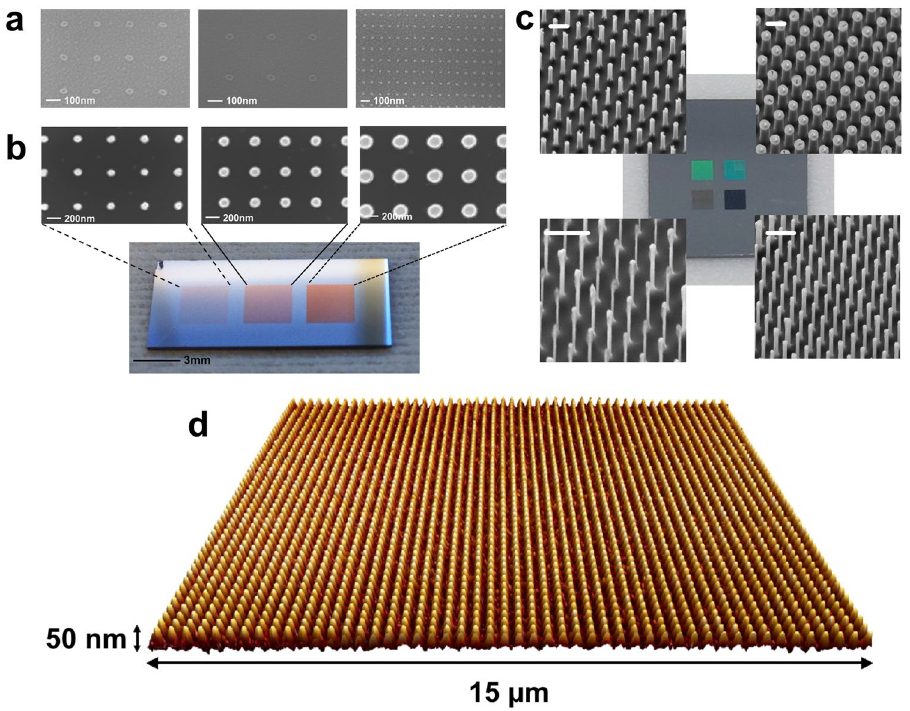
Figure 2. SEM, AFM and optical images of nanoarrays. ( a ) Scanning electron microscope (SEM) images of the HSQ nanodot arrays (height and diameter = 30 nm) fabricated on an ITO coated SiO 2 /Si substrate. The array period varies from 200 nm (left image), 300 nm (middle image) to 90 nm in the x-direction and 120 nm in the y-direction (right image). ( b ) Optical image of three sets of 3 mm × 3 mm gold nanodot arrays fabricated on a Si substrate. The array period is fixed at 500 nm. The SEM images show the corresponding diameters of the gold nanodots: 110 nm (left image), 170 nm (middle image) and 210 nm (right image). The optical image shows a difference in reflectivity intensities due to the difference of the fill factor of the gold nanodot array. ( c ) Optical image of four sets of 1.5 mm × 1.5 mm Si nanopillar arrays fabricated on a Si chip. The height (H) of the nanopillars is 950 nm. The optical reflectivity of the Si surface can be adjusted by the pillar diameter and array period. The SEM images show the corresponding array dimensions – bottom left image, array period (L) = 500 nm, diameter (D) = 110 nm; bottom right image L = 500 nm, D = 160 nm; top left image L = 1 µ m, D = 280 nm, top right image L = 1 µ m, D = 570 nm (scale bar = 1 µ m). ( d ) Atomic force microscopy (AFM) image of a 15 µ m × 15 µ m HSQ nanopillar array, illustrating the uniformity of the arrays fabricated by the FEBL